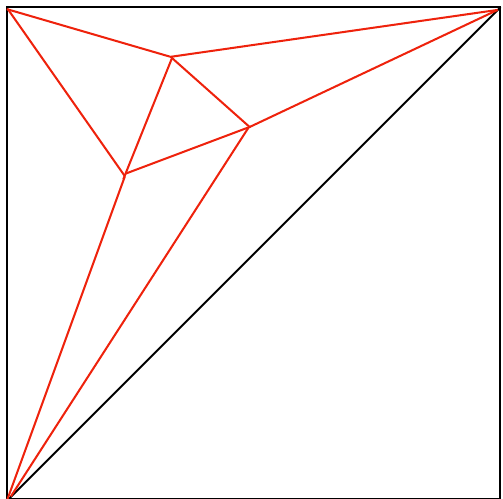
FIG. 6. An example of a crease pattern containing a fold joining two external vertices. Such folds do not couple to any others and we will not consider any crease patterns containing these (except for the individual butterflies in Sec. IV). This crease pattern also contains a “ triangulated triangle. ” All of the red folds above the upper left diagonal of the square lie within a triangle; hence, the three vertices interior to the triangle are rigid even though they each have four